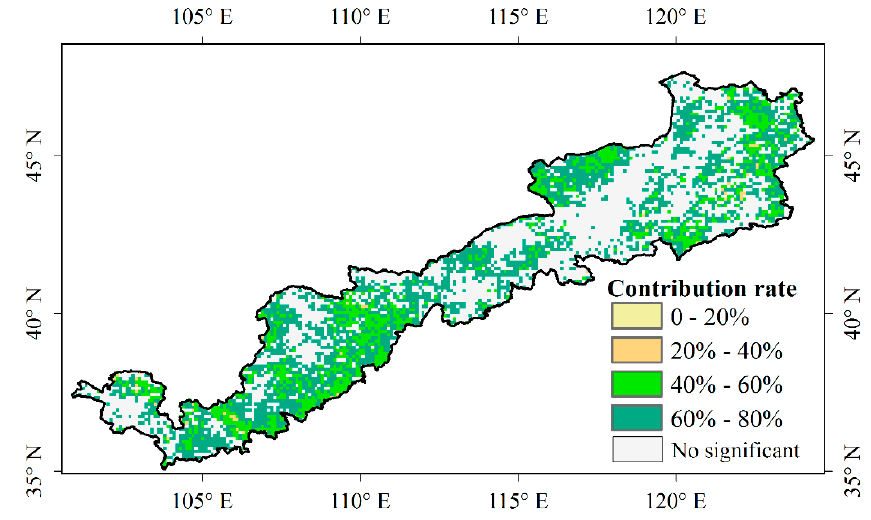
Figure 13. Spatial distribution of the total human activity contribution rate to NDVI dynamics during 1982–2015. Only pixels with P < 0.05 were presented.